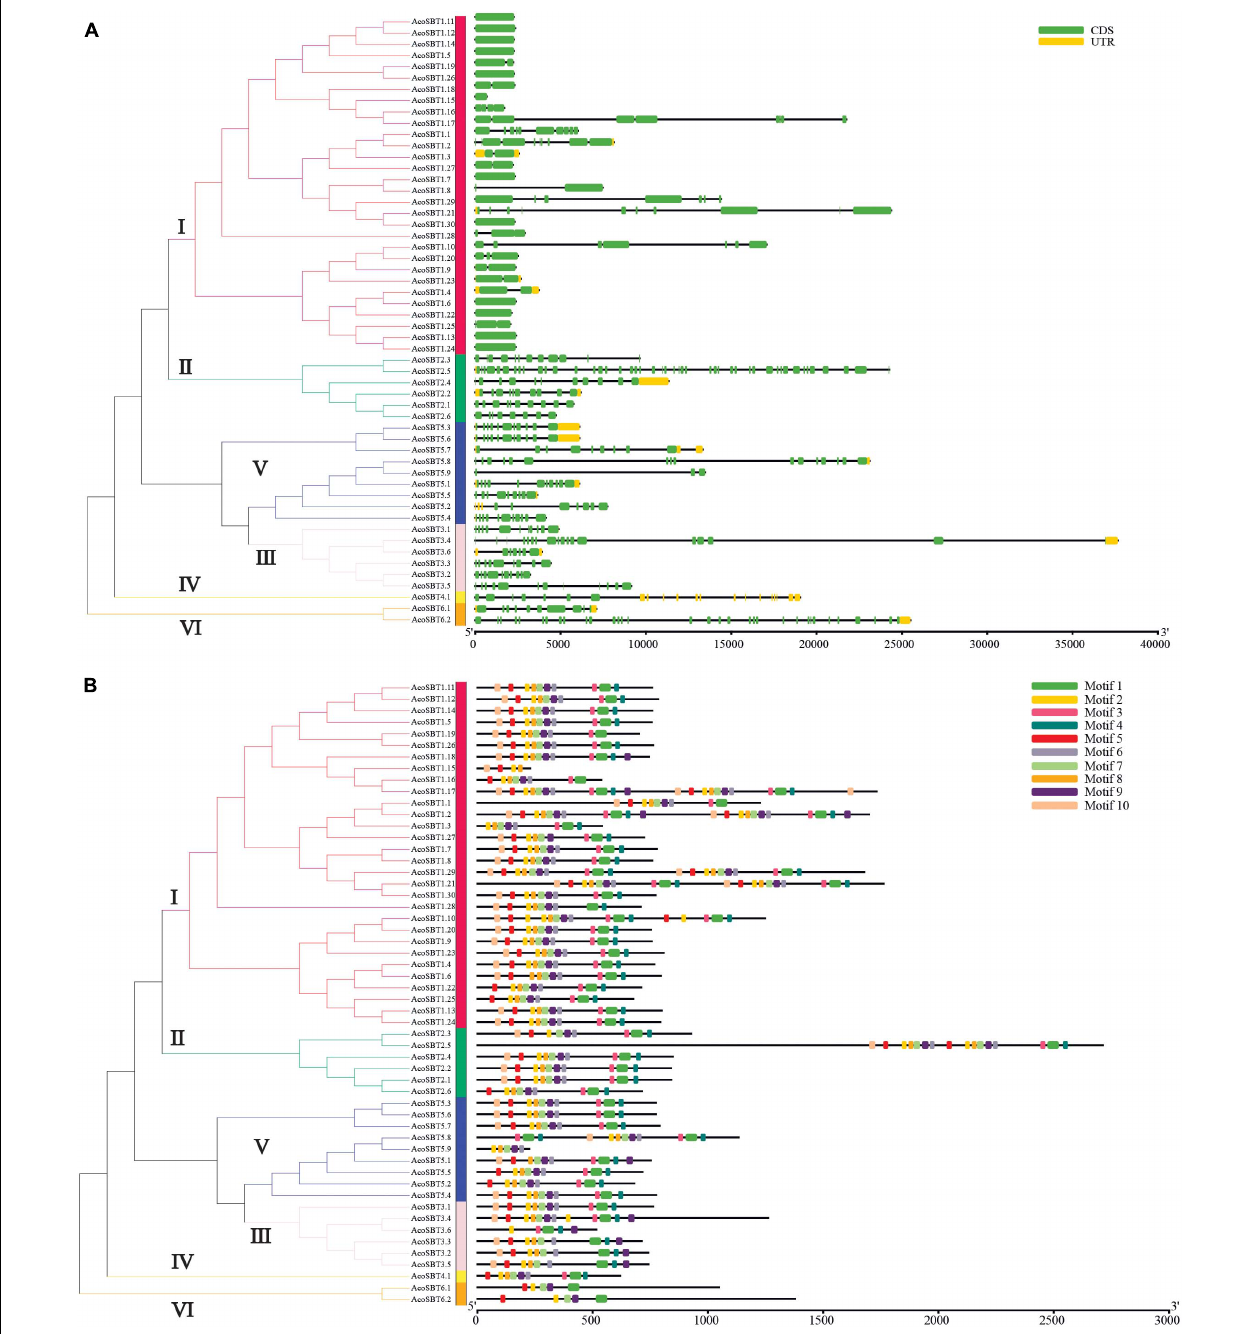
FIGURE 2 | Gene structure and architecture of conserved protein motifs. (A) The Exon-intron structure of AcoSBT s. Green boxes represent CDS regions, yellow boxes represent UTR regions, and black lines represent untranslated introns. (B) The conserved motif composition of AcoSBTs. Different motifs are displayed by boxes with different